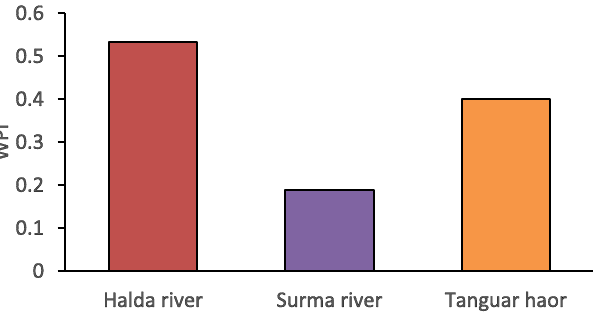
Figure 3. The water pollution index in different sampling stations.